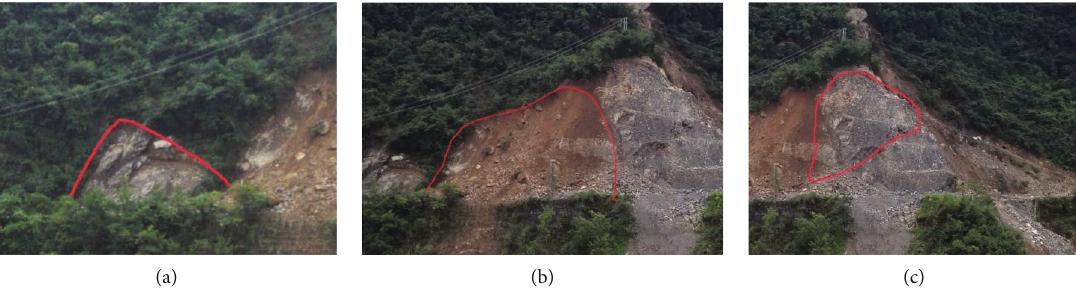
Figure 5: Location distribution of slump